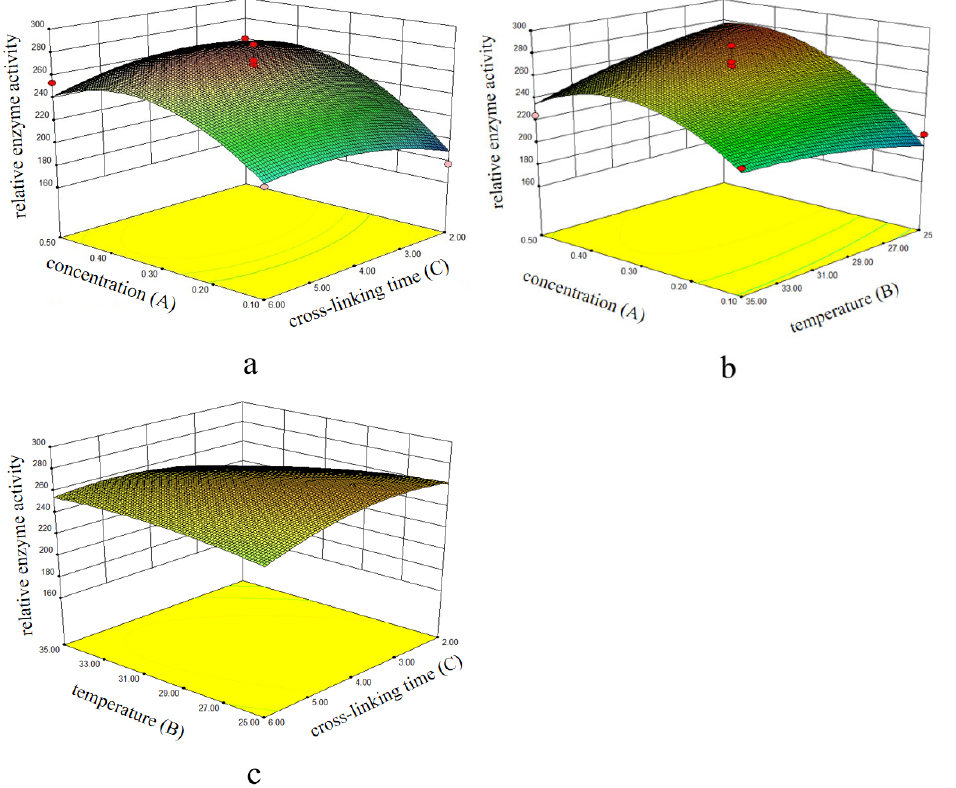
Figure 3. Response surface plot and immobilization efficiency. ( a ) Concentration of cross-linking agent vs. cross-linking time. ( b ) Concentration of cross-linking agent vs. cross-linking temperature. ( c ) Cross-linking temperature vs. cross ‐ linking time. Table 1. ANOVA and fi t statistics of the quadratic model for immobilization e ffi ciency. Model